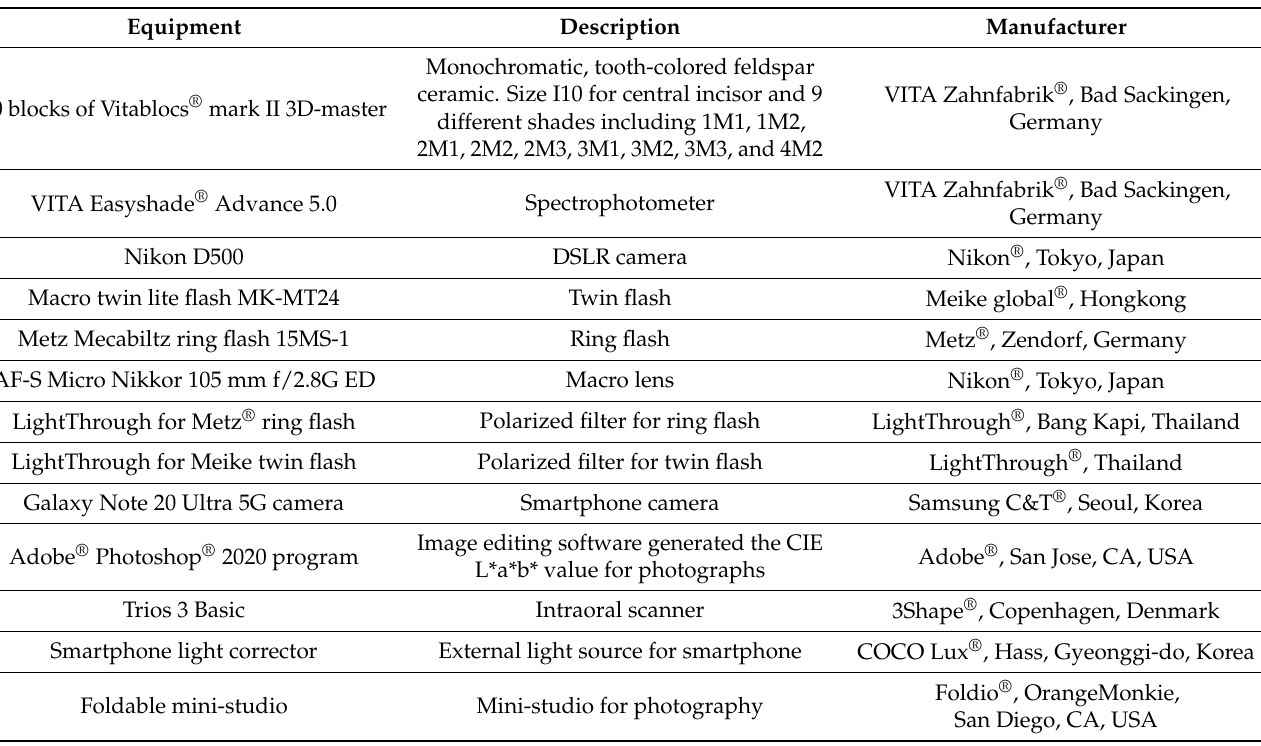
Table 1. Various instruments and software used in this